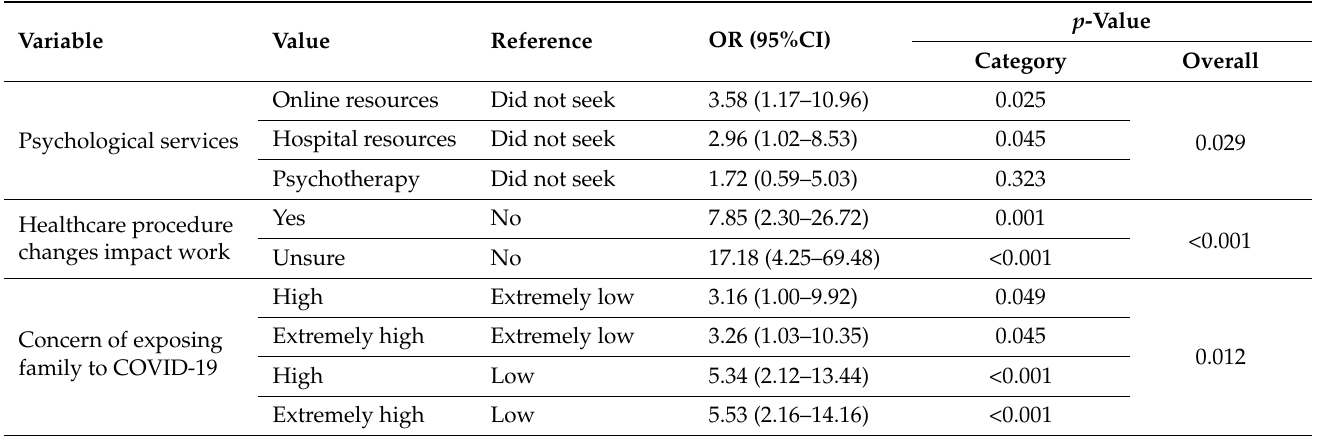
Table 5. Risk factors for depression by binary logistics